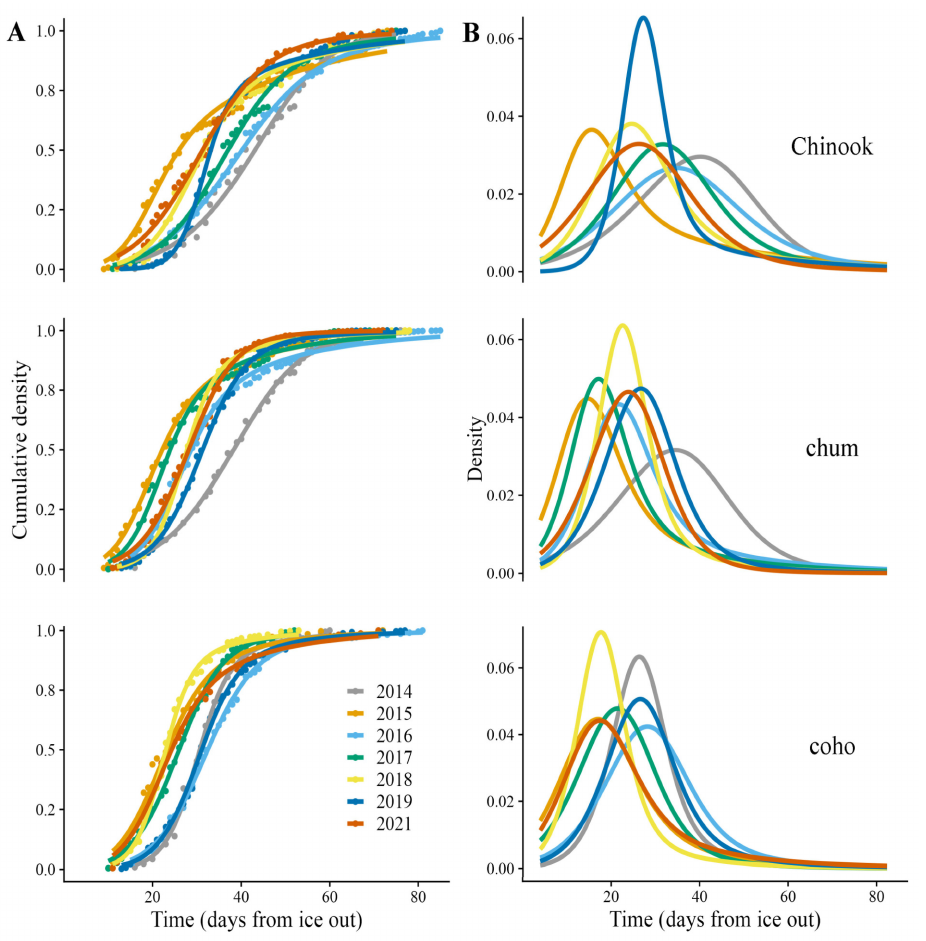
Figure 5. Modeled cumulative distributions ( A ) and probability densities ( B ) of migration probabili- ties for juvenile Chinook ( Oncorhynchus tshawytscha ), chum ( O. keta ), and coho salmon ( O. kisutch ) from the Yukon River, Alaska, 2014–2019 and